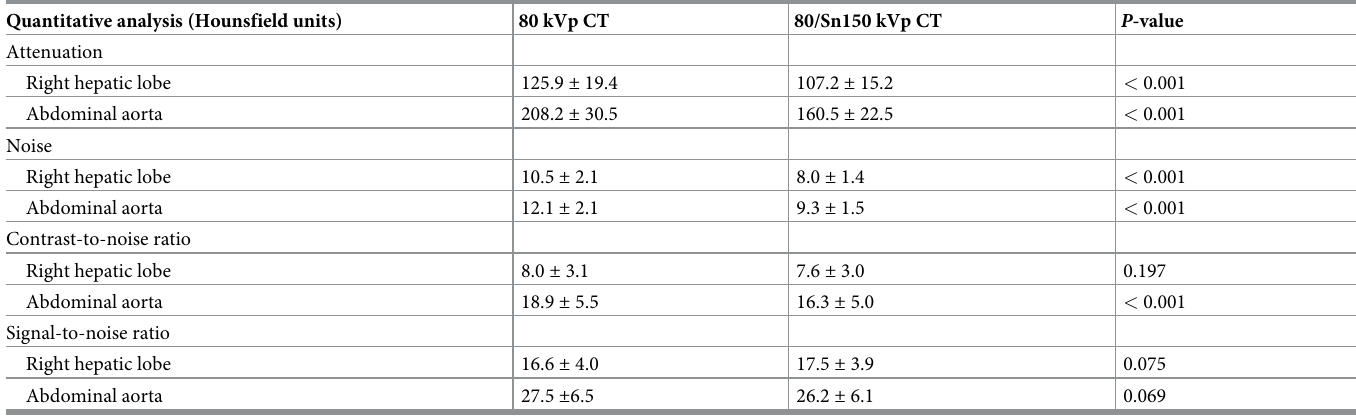
Table 3. Assessment of objective image quality.